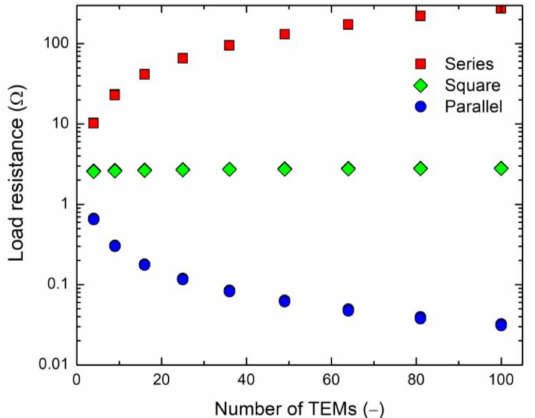
Figure 8. Load electrical resistance at the point of maximum output power for ATEGs with different number of TEMs using series, square and parallel configurations. Results for both operating points #1 and #2 are represented.